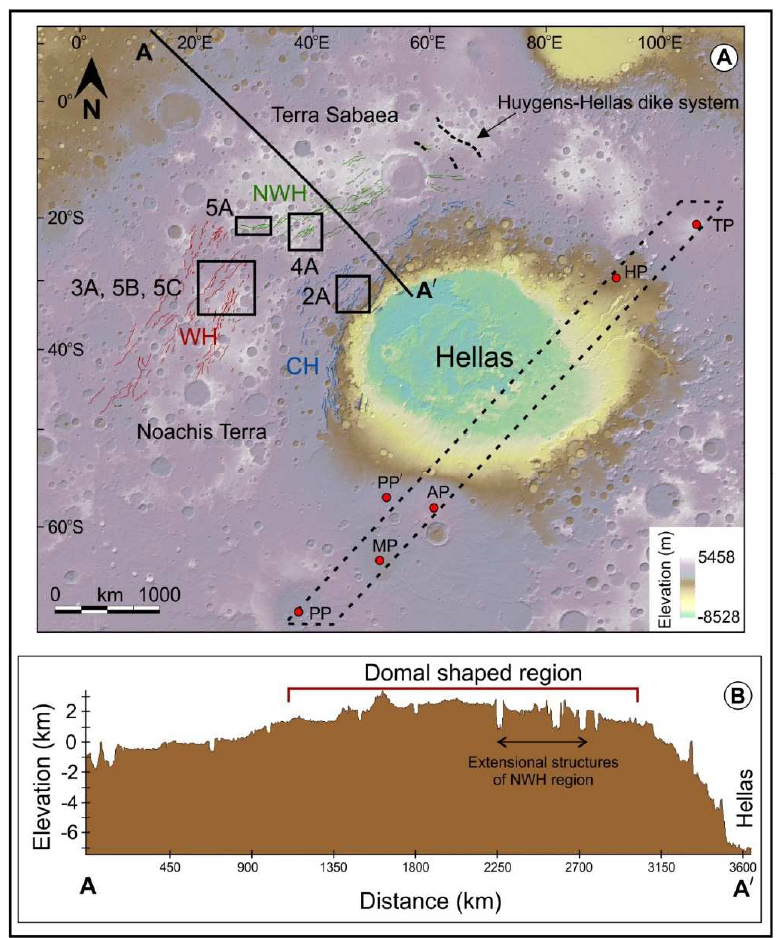
Figure 1. ( A ) Colorized elevation map showing the distribution of extensional structures around the Hellas basin. The red dots indicate the positions of Paterae associated with volcanism. CH: Circum Hellas structures (marked in blue lines); WH: Western Hellas (structures marked in red lines), NWH: North-western Hellas (structures marked in green lines); dashed parallelogram represents the linear orientation of Paterae in the Circum Hellas Volcanic Province (CHVP). A topographic profile transect (AA’) is shown in ( B ). AA’ shows the extensional structures on the top of the domal (~2 km) region. (PP: Pityusa Patera; MP: Malea Patera; PP’: Peneus Patera; AP: Amphitrites Patera; HP: Hadriaca Patera; TP: Tyrrhena Patera).